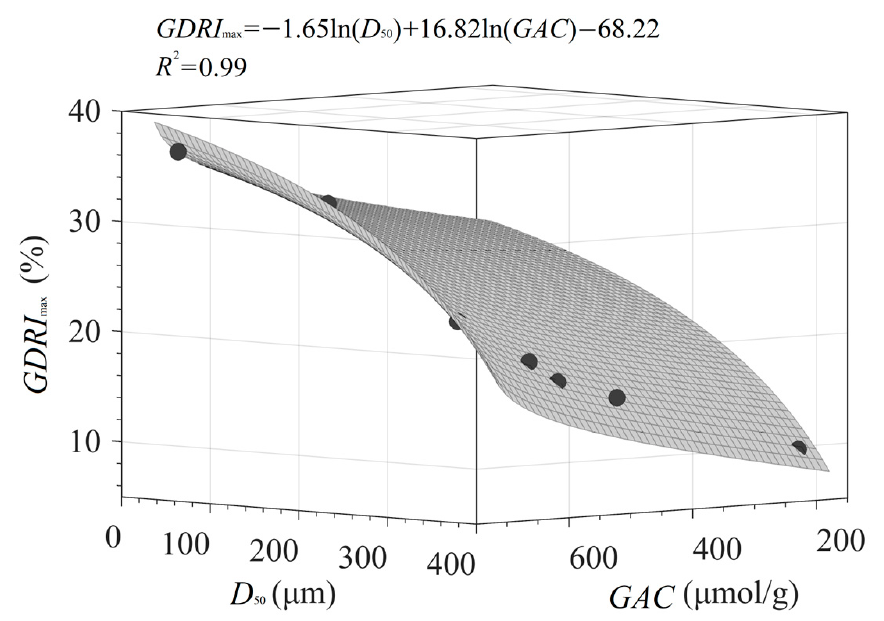
Figure 14. Quantitative relationship between D 50 , GAC , and GDRI max of PIDF.